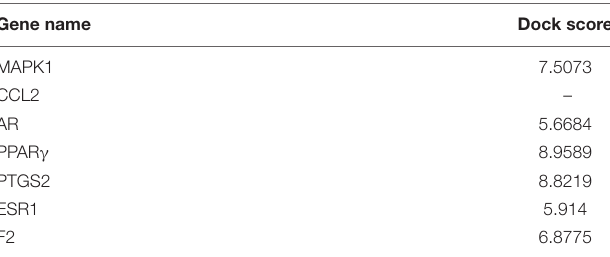
TABLE 2 | The dock score of seven protein targets.